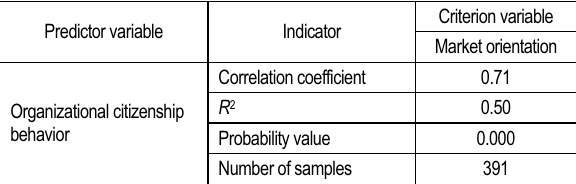
Table 5. The relationship between organizational citizenship behavior and customer orientation Predictor variable Indicator